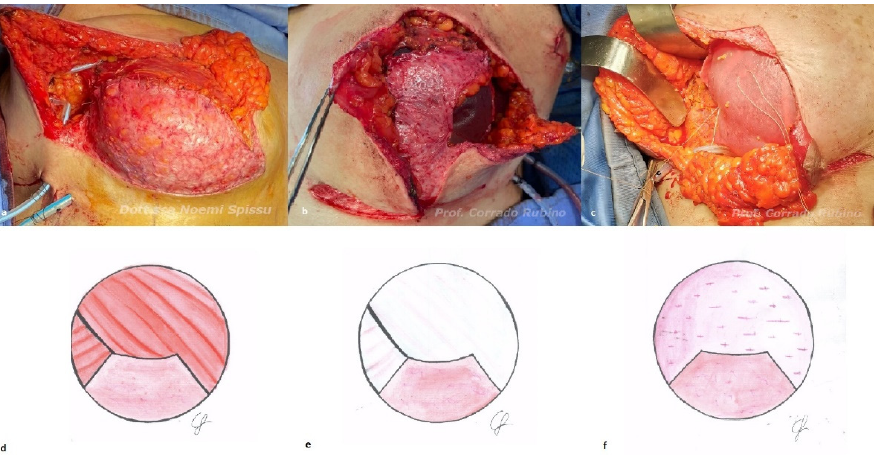
Figure 4. Intraoperative picture ( above ) and schematic drawing ( below ) of the three different options of implant coverage: ( a , d ) submuscular reconstruction; ( b , e ) pre-pectoral reconstruction and implant autologous coverage with fascial flaps; ( c , f ) pre-pectoral reconstruction with ADM.